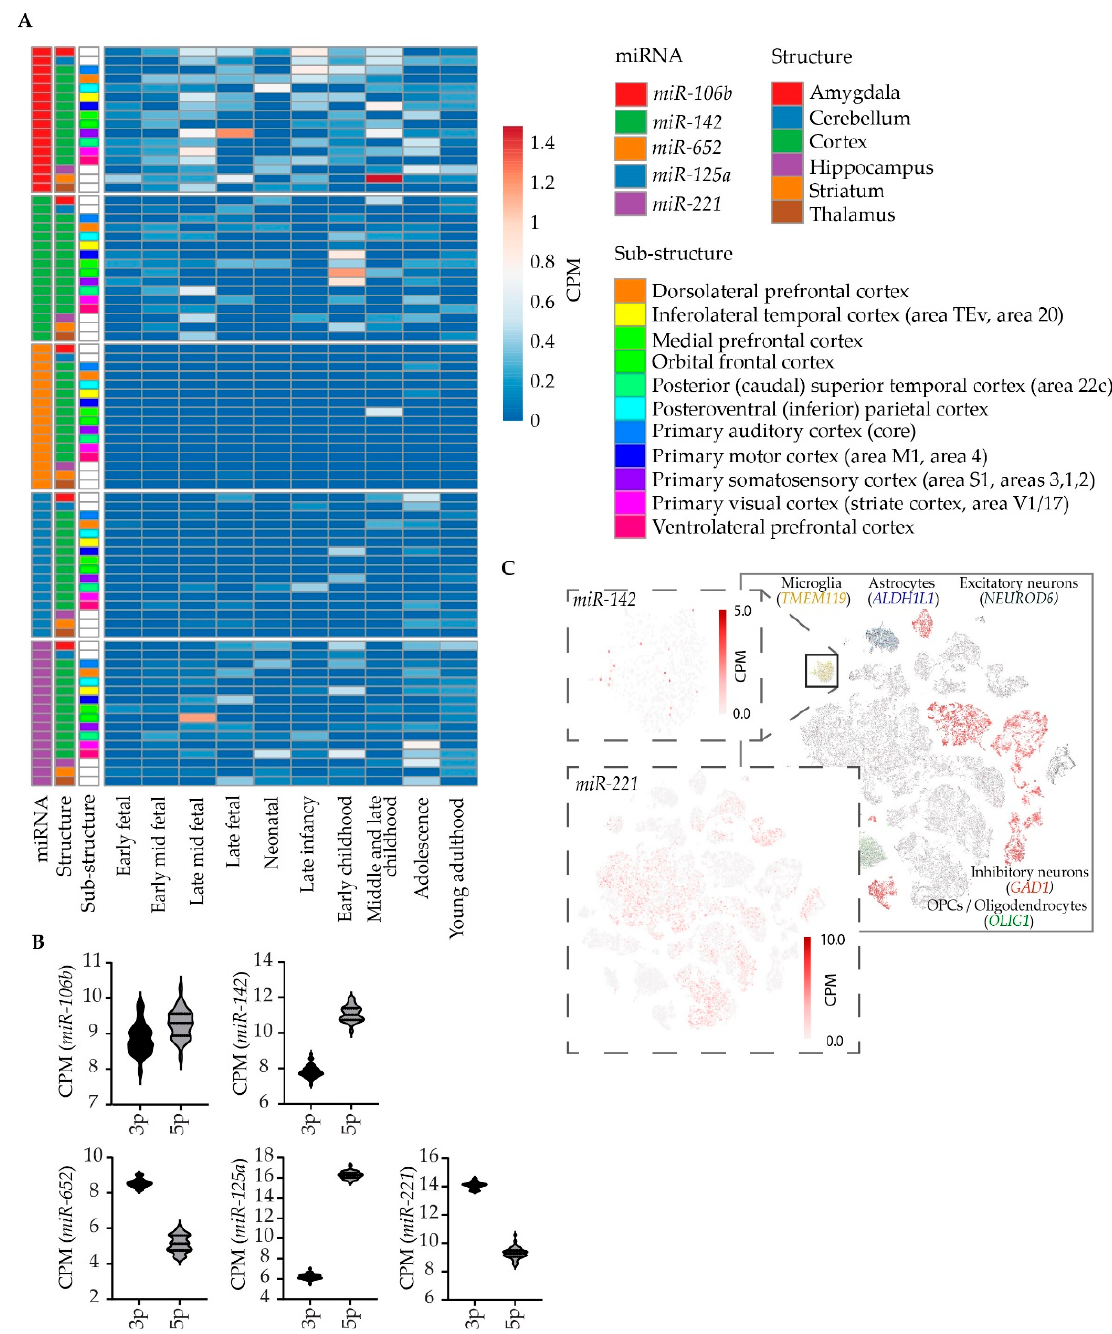
Figure 3. Expression characteristics of candidate miRNAs in the postmortem human brain and single nuclei derived from human brain tissue. ( A ) Plotted are the normalized expression values (RPKM) of putative miRNA biomarkers in multiple human brain tissues sampled throughout development. ( B ) Plotted are normalized expression (CPM) of single nuclei candidate miRNA strand-specific counts (5p and 3p) in adult human cortex. ( C ) Shown are normalized expression values for miR-142 and miR-221 in single cell sequencing data from human cortical tissue. For reference, markers of major brain cell types are shown.